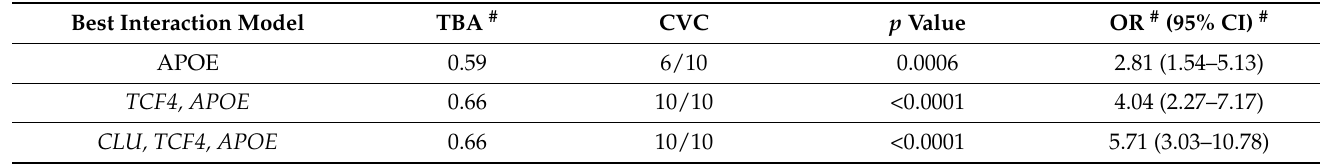
Table 5. Gene–gene interaction models by GMDR